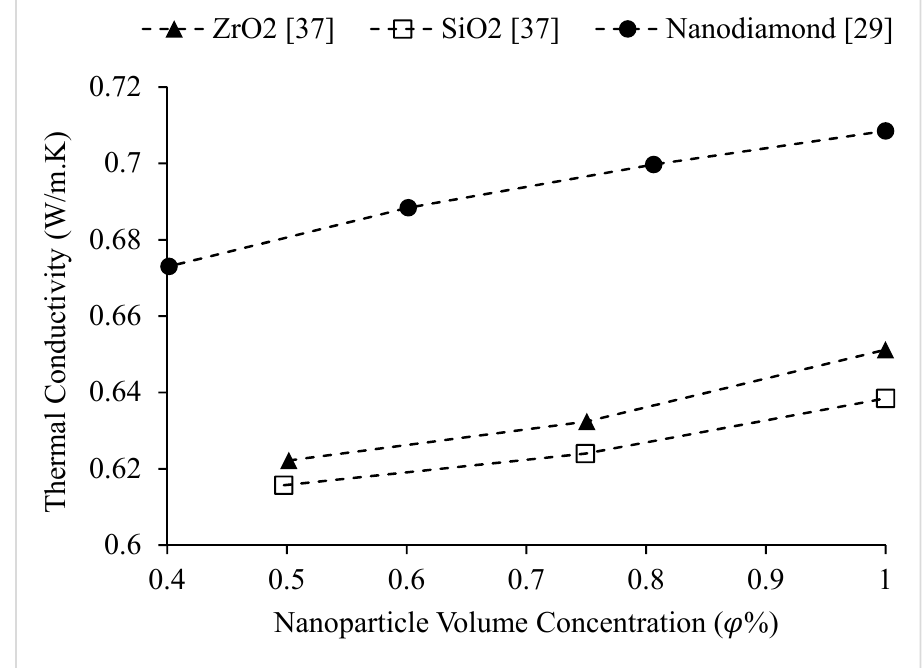
Figure 20. Variation of thermal conductivity of water-based nanofluids at room temperature as a function of nanoparticle volume concentration, 𝜑 , at concentrations below 𝜑 = 1%.